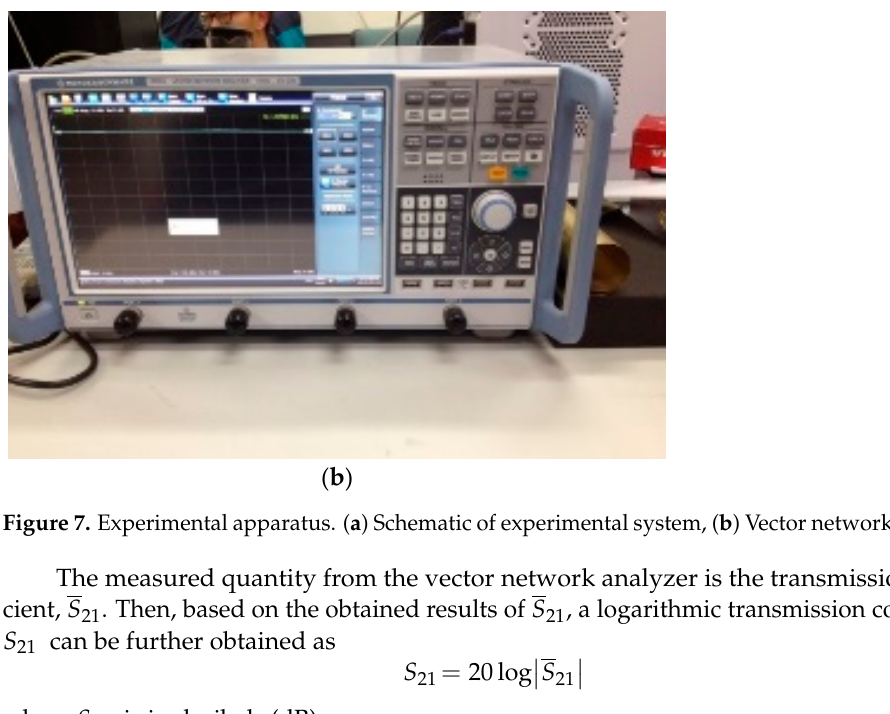
Figure 9. Transmission coefficient with SRR2.